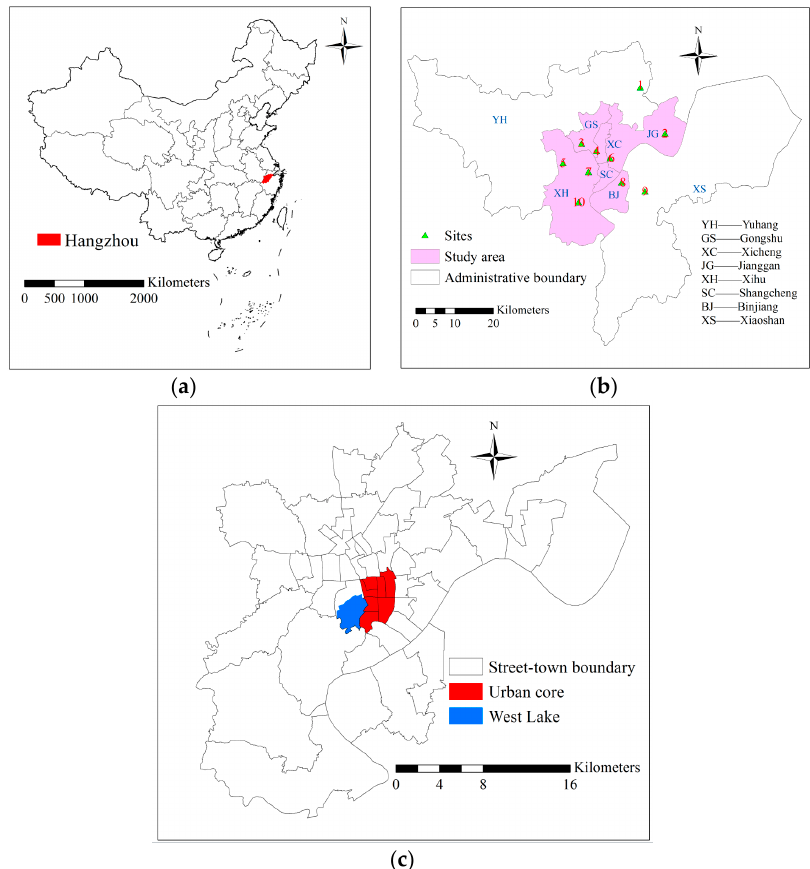
Figure 1. ( a ) Location of Hangzhou in China; ( b ) the spatial distribution of the 10 state-controlled monitoring sites in the eight districts of Hangzhou; ( c ) the street-town boundary, West Lake, and the urban core of the study area.